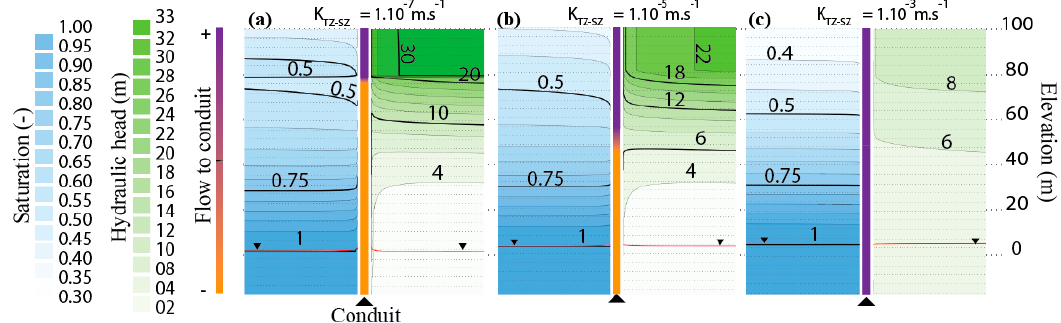
Figure 6. Profiles of the saturation (blue) and hydraulic head (green) around the conduit for various values of hydraulic conductivity of the transmission and saturated zones. Each profile is taken at the time step for which the flux at the bottom output of the model is maximum. ( a ) K TZ-SZ = 10 − 7 m/s. ( b ) K TZ-SZ = 10 − 5 m/s. ( c ) K TZ-SZ = 10 − 3 m/s.